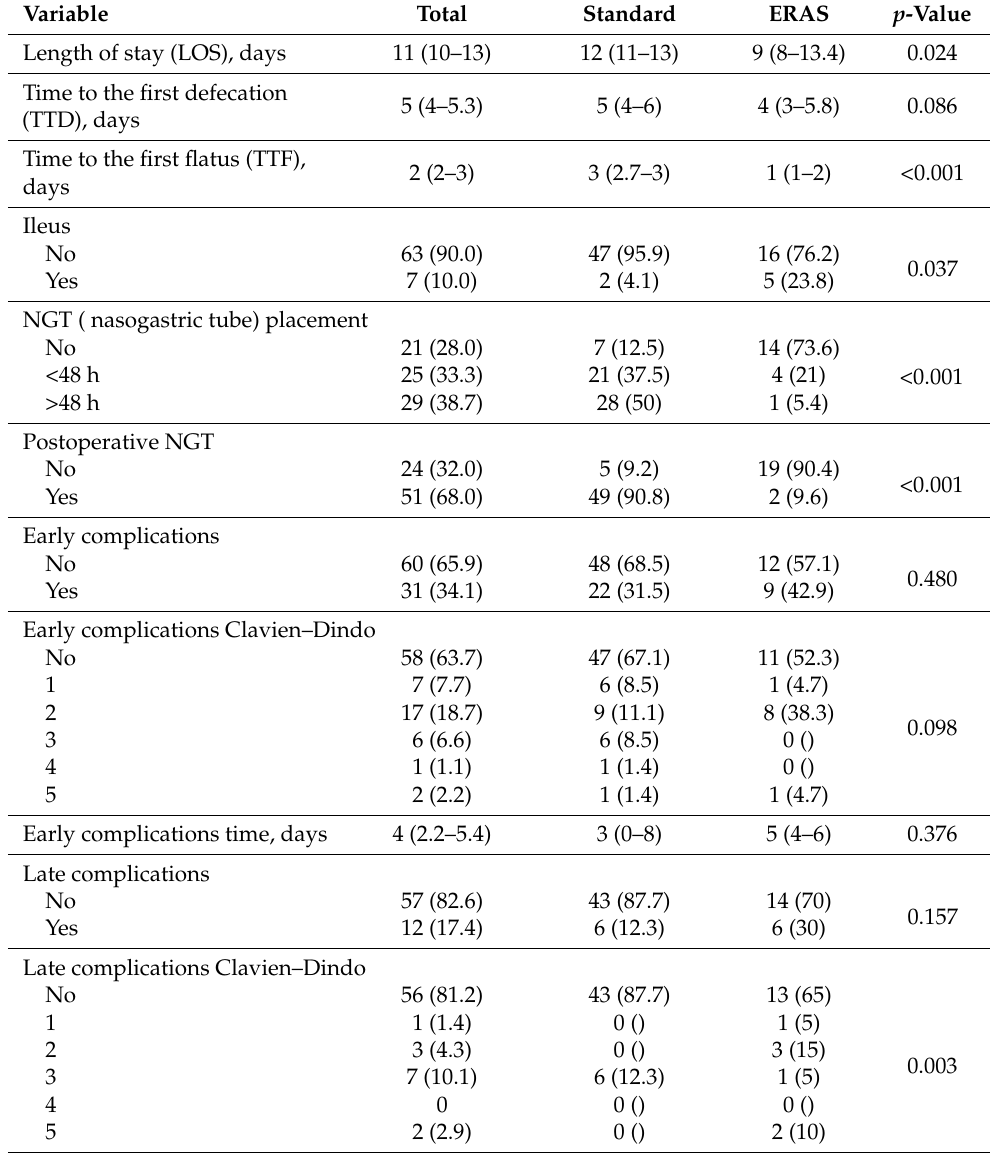
Table 4. The postoperative